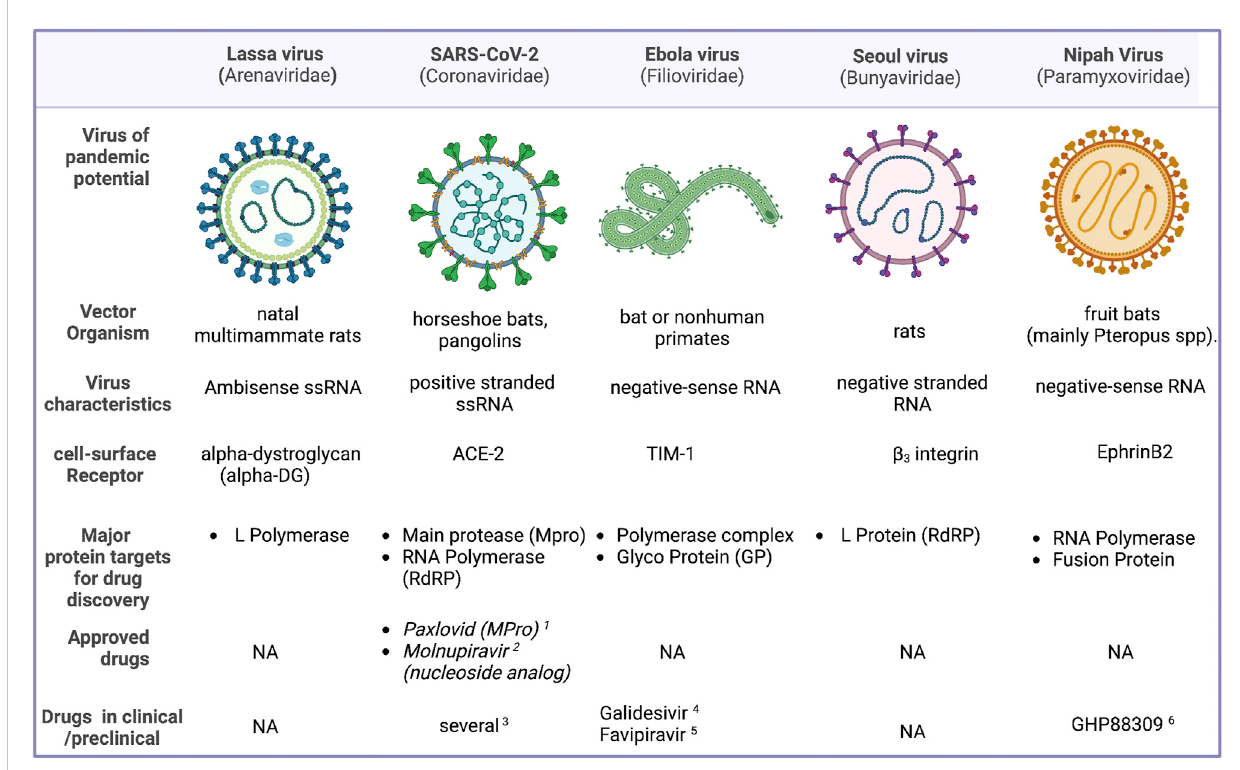
FIGURE 1 An overview of someof theviruses that are considered to have ahigh potential to causeapandemic,their structural features, major targets for drug developmentandpotentialdrugcandidates.1)(Owenetal.,2021).2)(Kabingeretal.,2021).3)(Bolarinetal.,2021).4)(Julanderetal.,2021).5)(Bixleretal., 2018). 6) (Cox et al.,